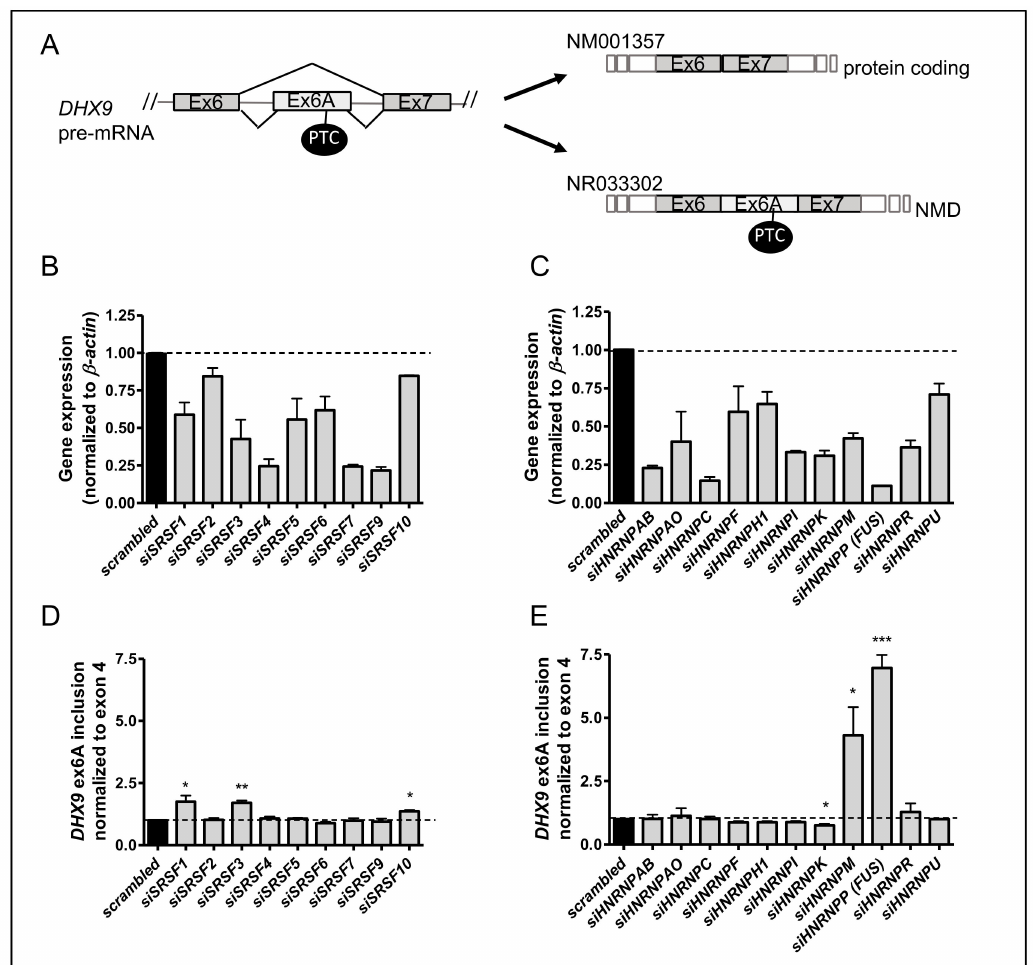
Figure 3. Regulation of DHX9 alternative splicing. ( A ) Schematic representation of the alternative splicing of exon 6A in DHX9 pre-mRNA. Exclusion of the poison exon 6A in DHX9 mRNA leads to the main transcript (NM001357) encoding the full-length DHX9 protein (upper part). Exon 6A inclusion leads to the alternative noncoding transcript NR033302, containing a premature stop codon (PTC) and targeted to the NMD machinery. ( B – E ) Histograms represents RT-qPCR analysis of a siRNA library to downregulate the expression of SR proteins ( B ) (one-way ANOVA p -value < 0.0001; Bonferroni correction for siSRSF6 p -value < 0.05; siSRSF1 and siSRSF5 p -value < 0.005; siSRSF3 , siSRSF4